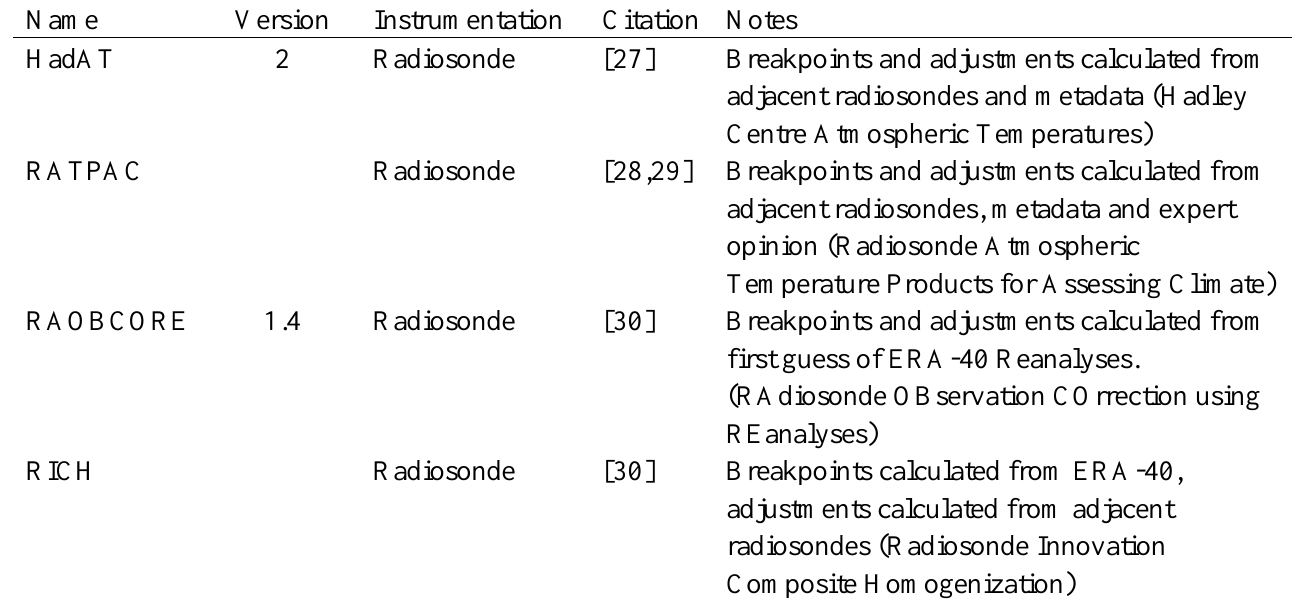
Table 1. Listing of references for the various datasets used in this study. Acronyms are spelled out in the ―Notes‖